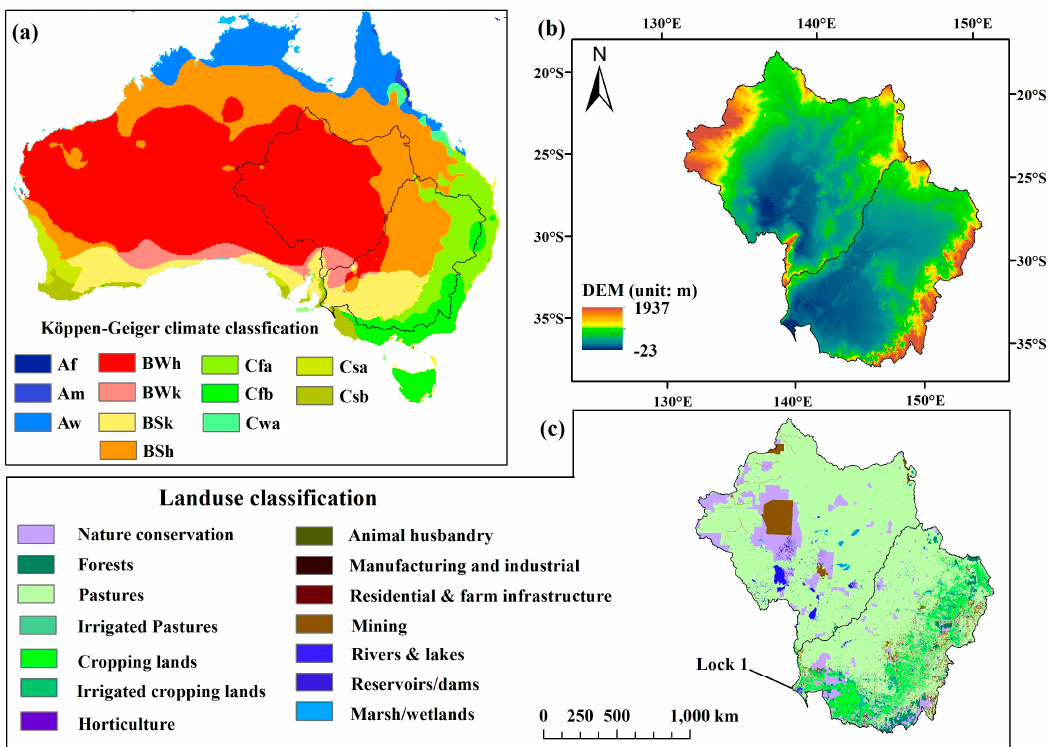
Figure 1. ( a ) Location map of the Murray-Darling and Lake Eyre Basin with climate zone according to the Koppen–Geiger classifications (adapted from [37]): A, equatorial; B, arid; C, warm temperate; W, desert; S, steppe; f, fully humid; s, summer dry; m, monsoonal; w, winter dry; h, hot arid; k, cold arid; a, hot summer; b, warm summer. ( b , c ) Digital elevation model (DEM) and land use maps were accessed from [38,39], respectively.